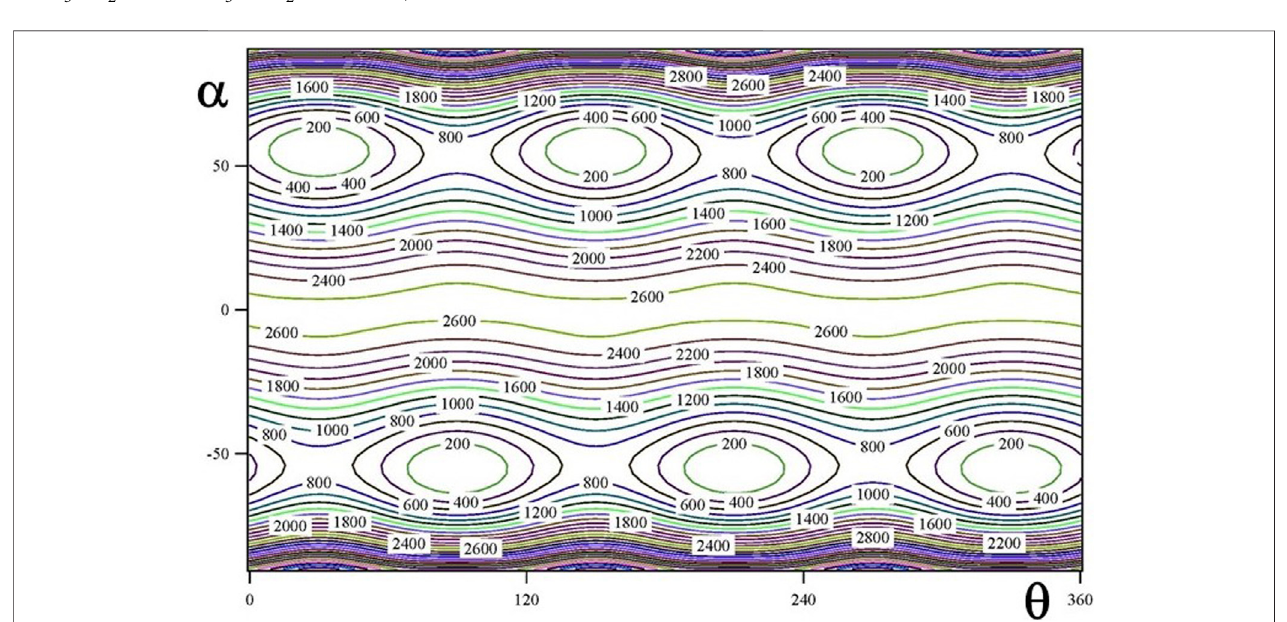
FIGURE 3 | V eff ( α , θ ; β (cid:1) 106 ° ) two dimensional potential energy surface (in cm − 1 ).